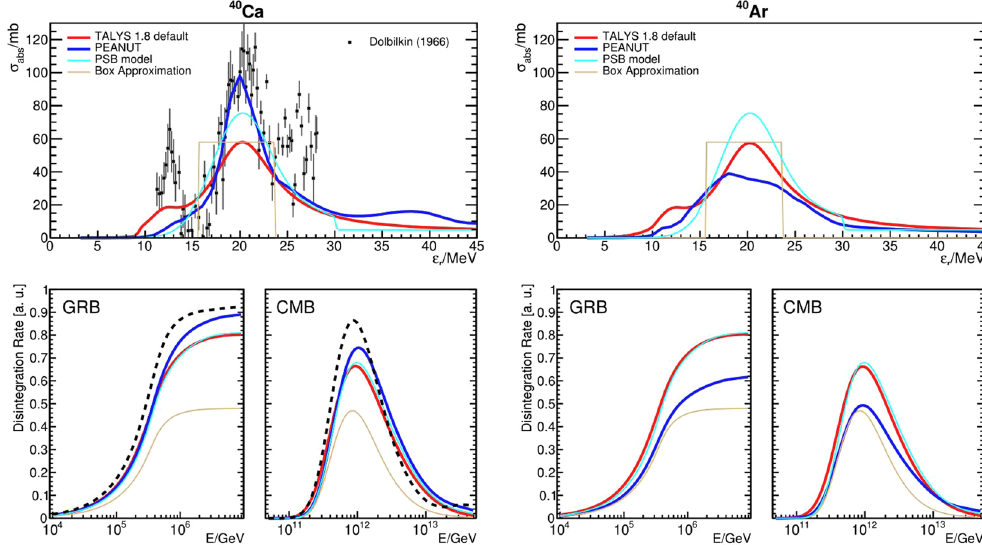
Figure 2. Comparison of cross sections (upper row) and disintegration lengths (lower row) for the isobar nuclides 40 Ca (left column) and 40 Ar (right column). The total absorption cross sections for photo-disintegration are shown as a function of the energy ε in the nucleus’ rest frame, where data are shown if available. The r corresponding Lorentz factor of the nucleus is given by ε / ε , where ε is the energy of the photons in the r observer’s frame (see the Supplementary Material for additional information). The different curves correspond to models as given in the plot legend, where the GDR box approximation is based in the assumptions in ref. 30. The corresponding disintegration rates are calculated at redshift z = 0 as a function of the observed energy; the corresponding Lorentz factor of the nucleus is given by E / m A , where m A is the mass of the nucleus. The disintegration rates are calculated for two different target photon spectra: for the GRB spectrum, a broken power law with spectral indices − 1 and − 2 and a break at 1 keV (energies in shock rest frame) has been assumed, whereas the CMB spectrum refers to the cosmic microwave background at redshift zero, i . e ., a thermal target photon spectrum with T = 2.73 K. Dashed lines refer to disintegration rates calculated for measured cross